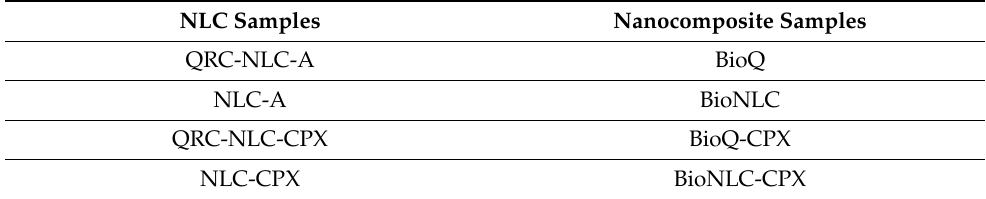
Table 2. List of prepared